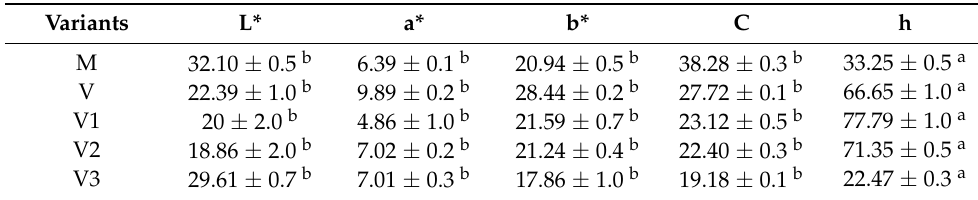
Table 4. Color parameters of rosehip jellified